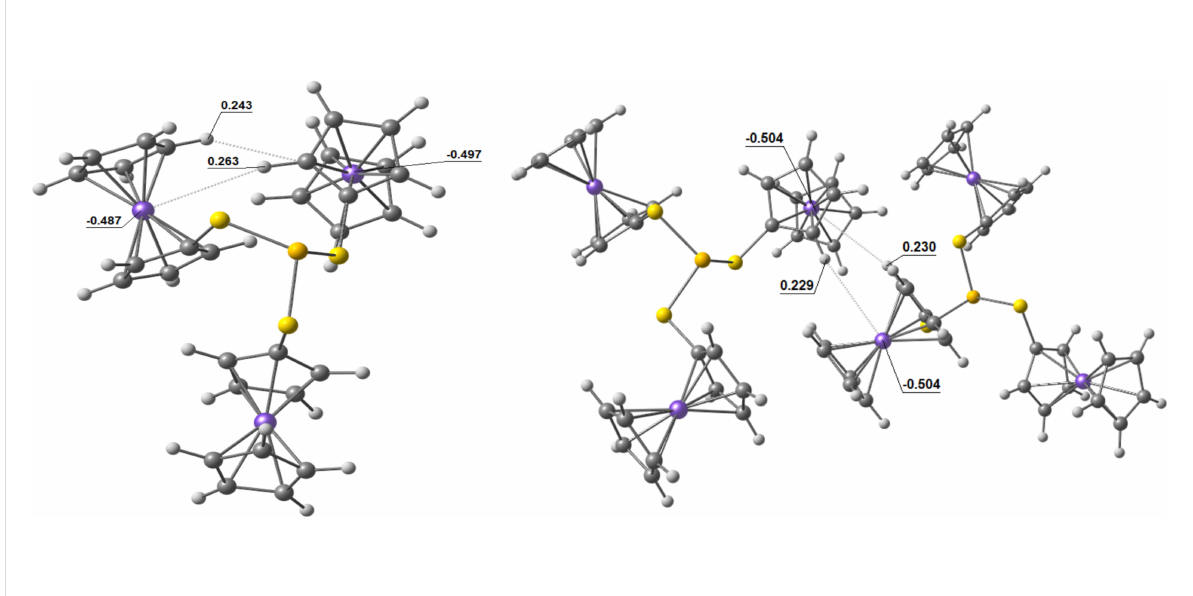
Figure 3: Calculated NBO charges on the Fe ions and hydrogen atoms for the optimized ttg conformer (left) and for two neighboring molecules (right) from X-ray analysis data.